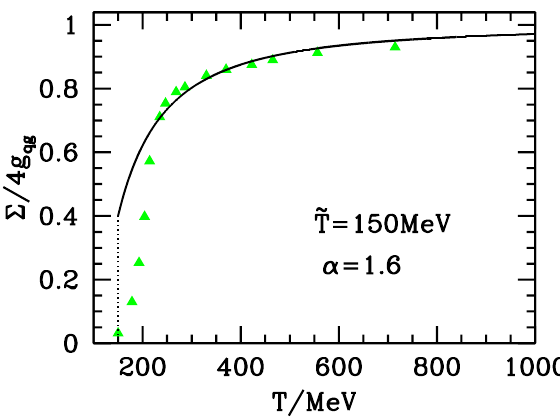
Figure 2. Expression (6) vs. lattice outputs (see text) given by green triangles. The analytic curve does not meet the five lowest– T points but is a fair approximation at greater temperatures. It is terminated at the temperature ˜ T , where p would become